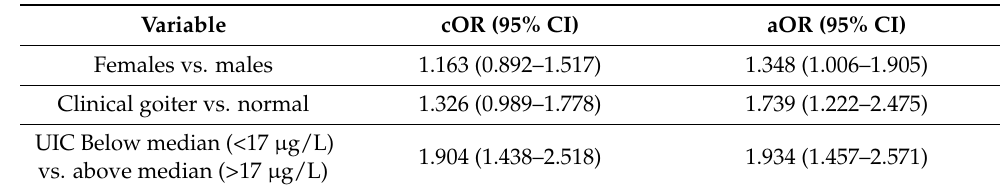
Table 2. Univariate and multivariable analysis for factors associated with stunting among school children ( n = 3046).